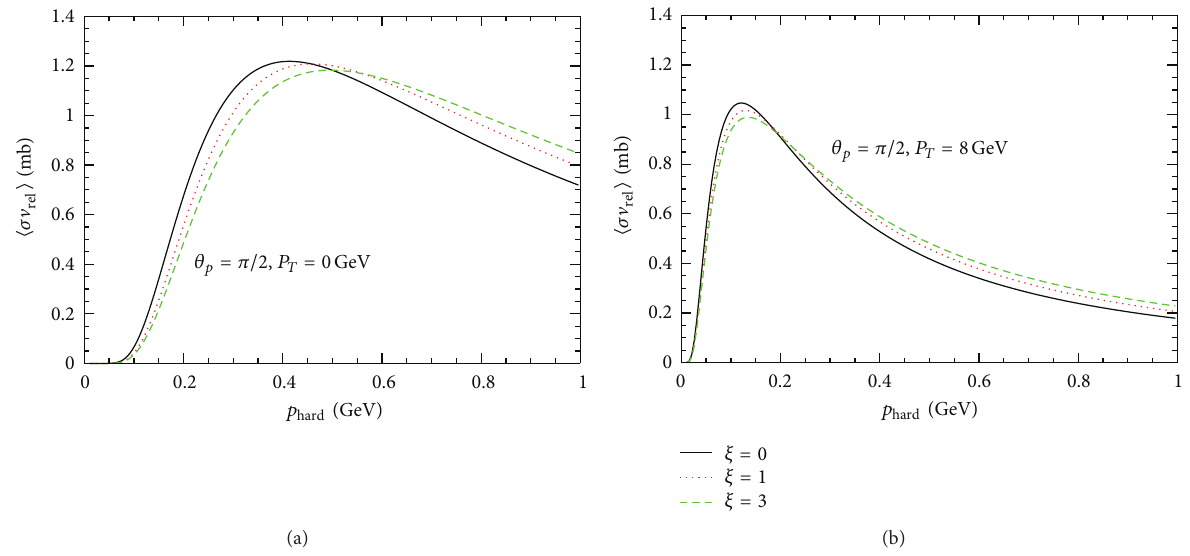
Figure 4: (Color online) The thermal-averaged gluon 𝐽/𝜓 dissociation cross-section as function of the hard momentum scale at central rapidity ( 𝜃 𝑝 = 𝜋/2 ) for 𝜉 = {0,1,3,5} . (a) corresponds to 𝑃 𝑇 = 0 and (b) is for 𝑃 𝑇 = 8 GeV.